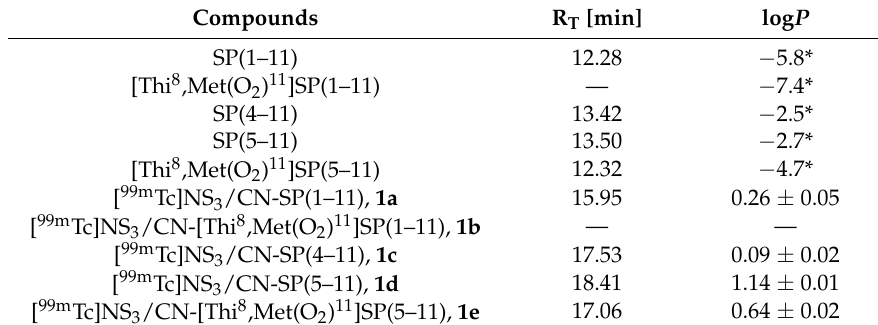
Table 1. Physico-chemical properties of SP fragments used in the work and [ 99m Tc]NS 3 /CN-SP radiobioconjugates (R T values were determined using HPLC (system 2)).